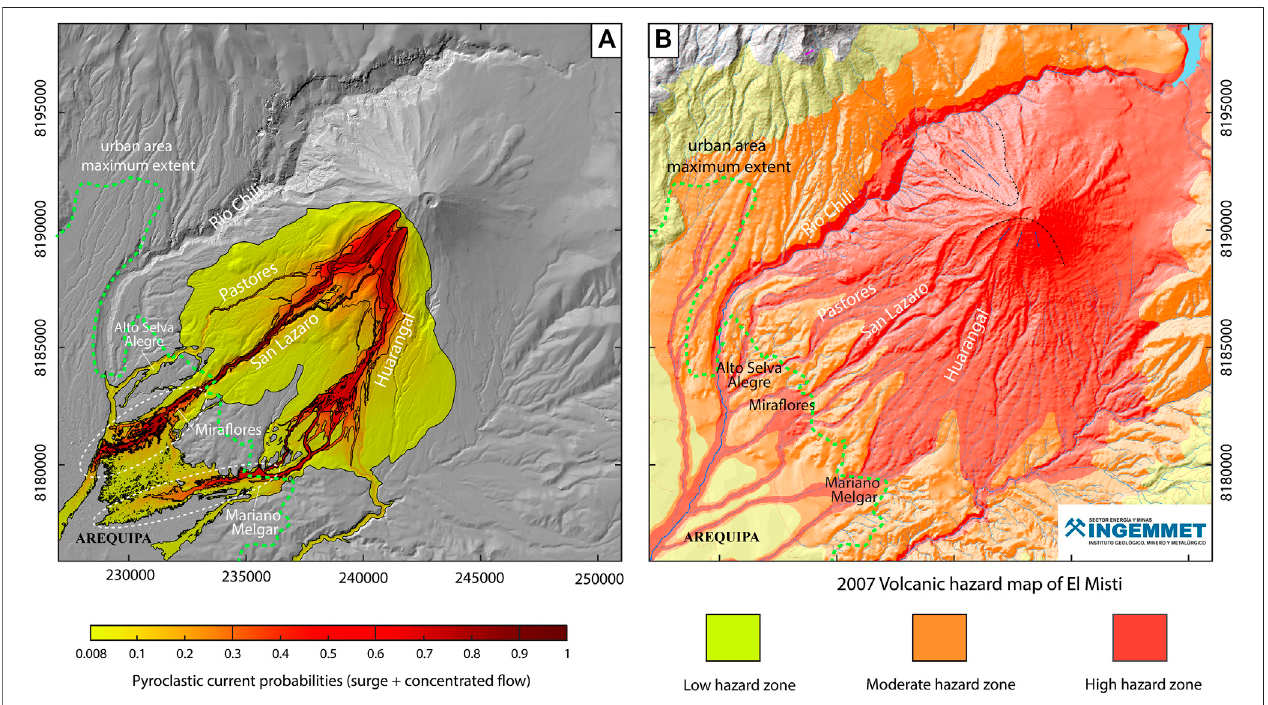
FIGURE10| ComparisonofthemapofcumulativepyroclasticcurrentprobabilitiesforboththeSanLázaroandHuarangalvalleys (A) tothe2007hazardmapofEl MistiVolcano (B) publishedbyINGEMMET(Mariñoetal.,2007).WhitedashedellipsoidsindicatethemainoverbankpyroclasticcurrentareasintheArequipaurbanarea.